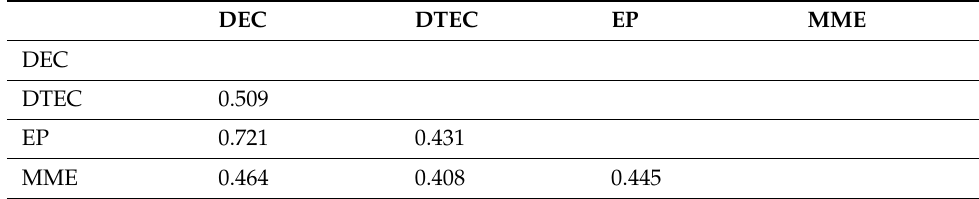
Table 5. Heterotrait-monotrait ratio